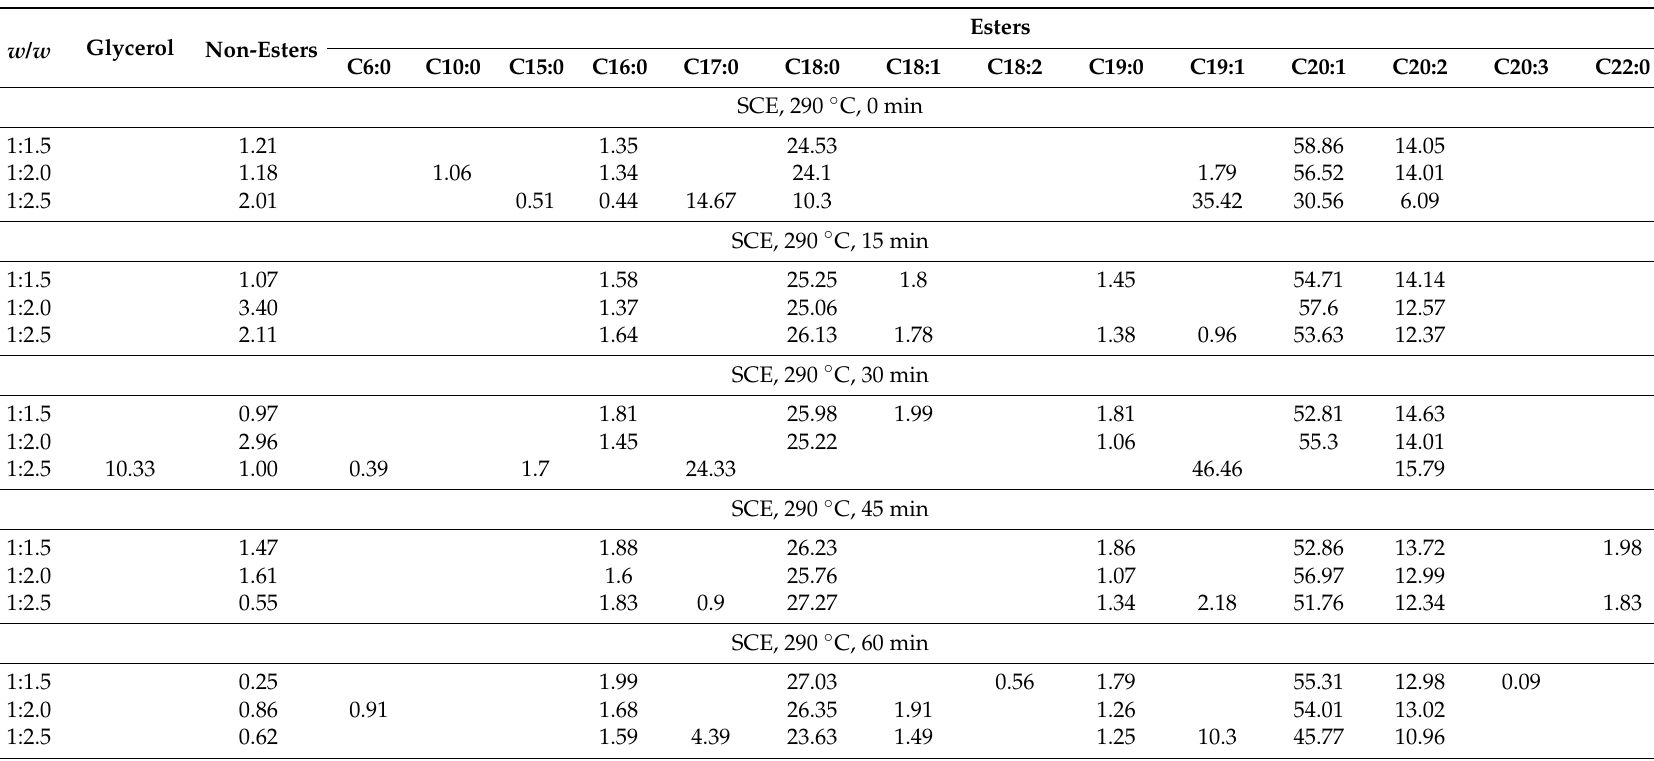
Table 6. The weight percentage of compounds according to the carbon number of liquid products obtained at different holding times for different waste pig fat to ethanol ratios at transesterification temperature of 290 ◦